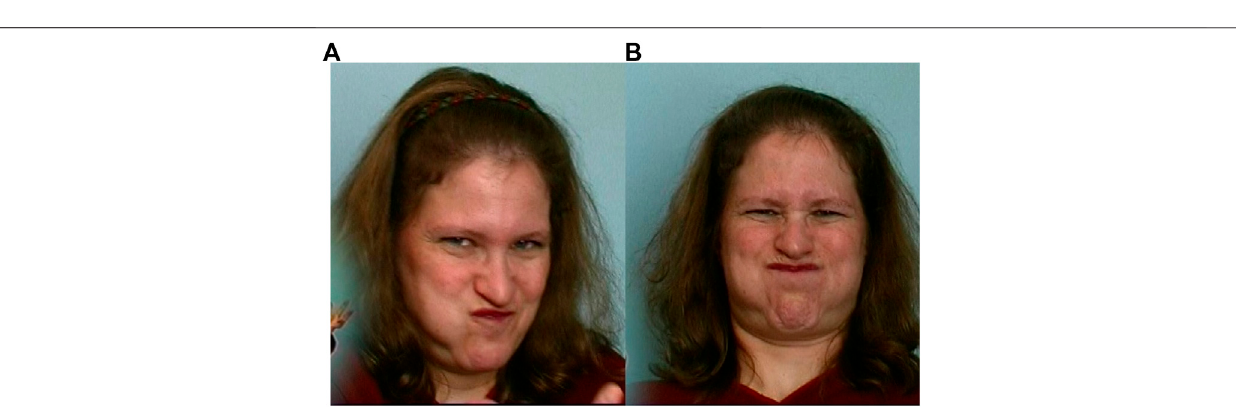
FIGURE 9 | Idiosyncracy and context-sensitivity. The same facial gestural conglomerate (Facial Action Units 8, 14, 17, 18, and 25) can mean “ narrow space ” as in (A) , or “ swinging — whoosh, ” as in (B) (from Sandler, 2009)